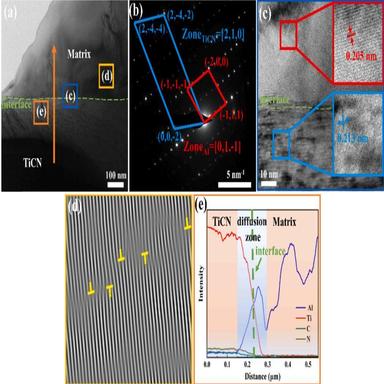
TEM analysis of as-built 2024-5 vol% TiCN composite, (a) TEM image of the interface between 2024 Al alloy matrix and TiCN particles, (b) the SAED of the interface region, (c) the high-resolution TEM image at the selected interface region in (a), (d) IFFT micrograph of the selected region in (a), and (e) the element content profiles of Al, Ti, C, and N across the TiCN-2024 Al alloy matrix interface.